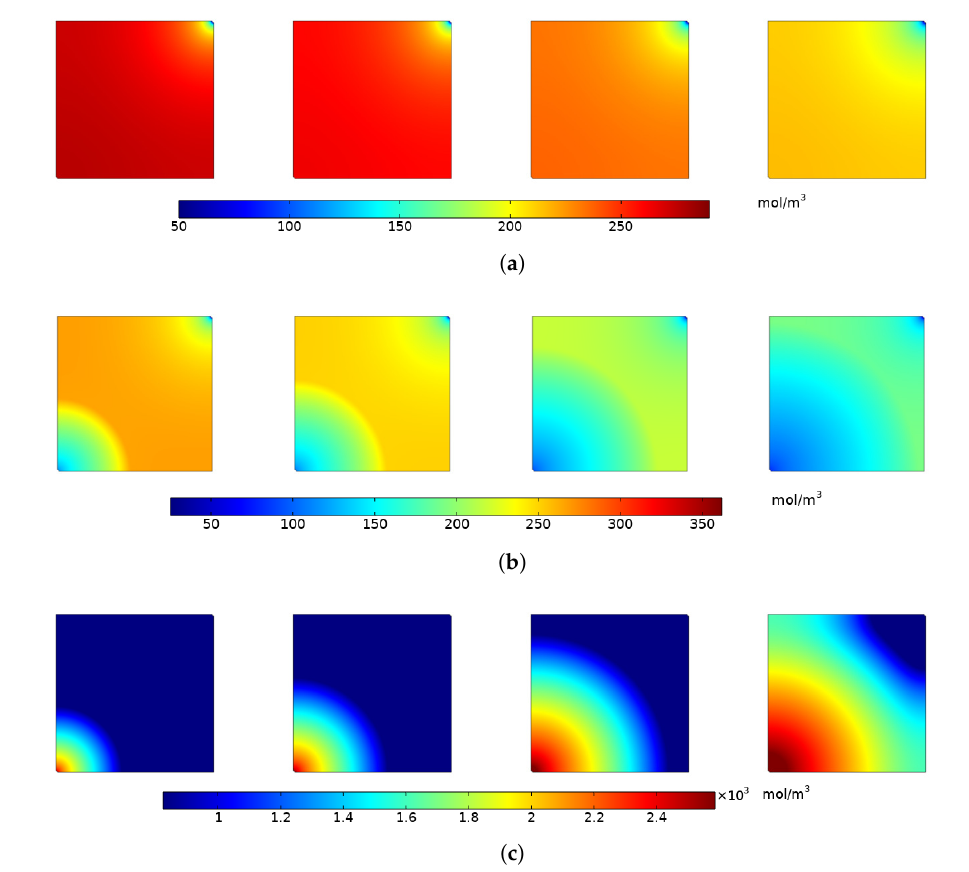
Figure 11. 300 days, 500 days, 1000 days, 1500 days ( a ) Distribution cloud diagram of adsorbed CH 4 in CBM ( b ) adsorption cloud diagram of adsorbed CH 4 in CO 2 - ECBM ( c ) adsorption cloud diagram of adsorbed CO 2 in CO 2 - ECBM